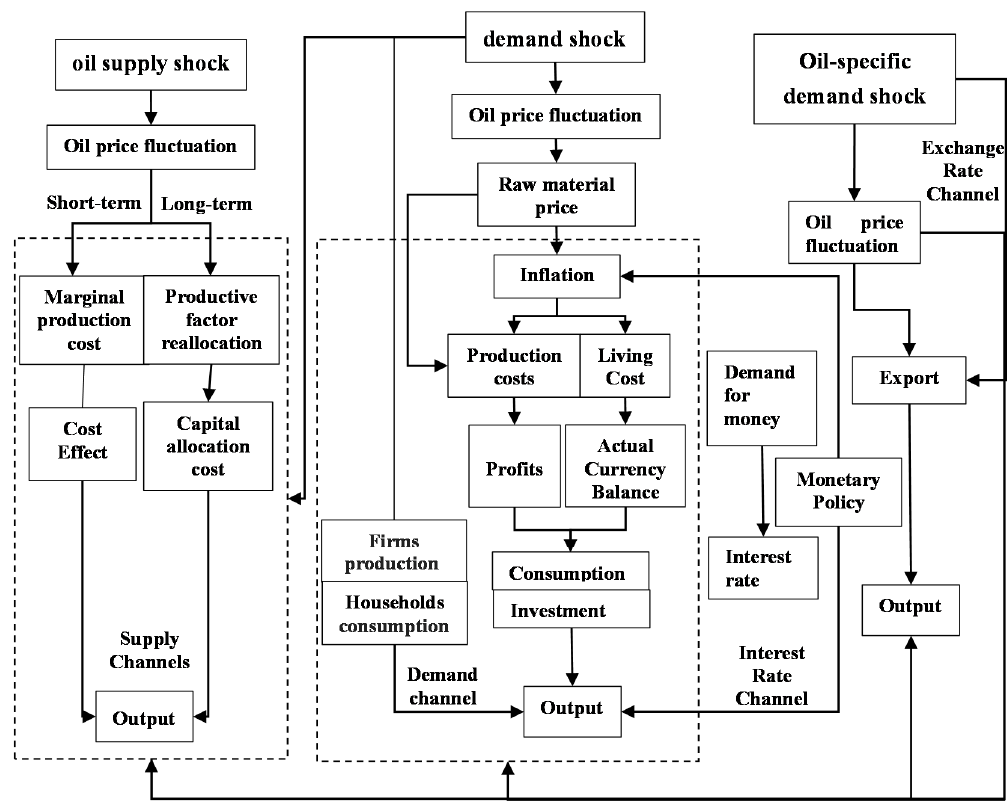
Figure 7. Transmission channels of the diverse sources of oil price shocks.